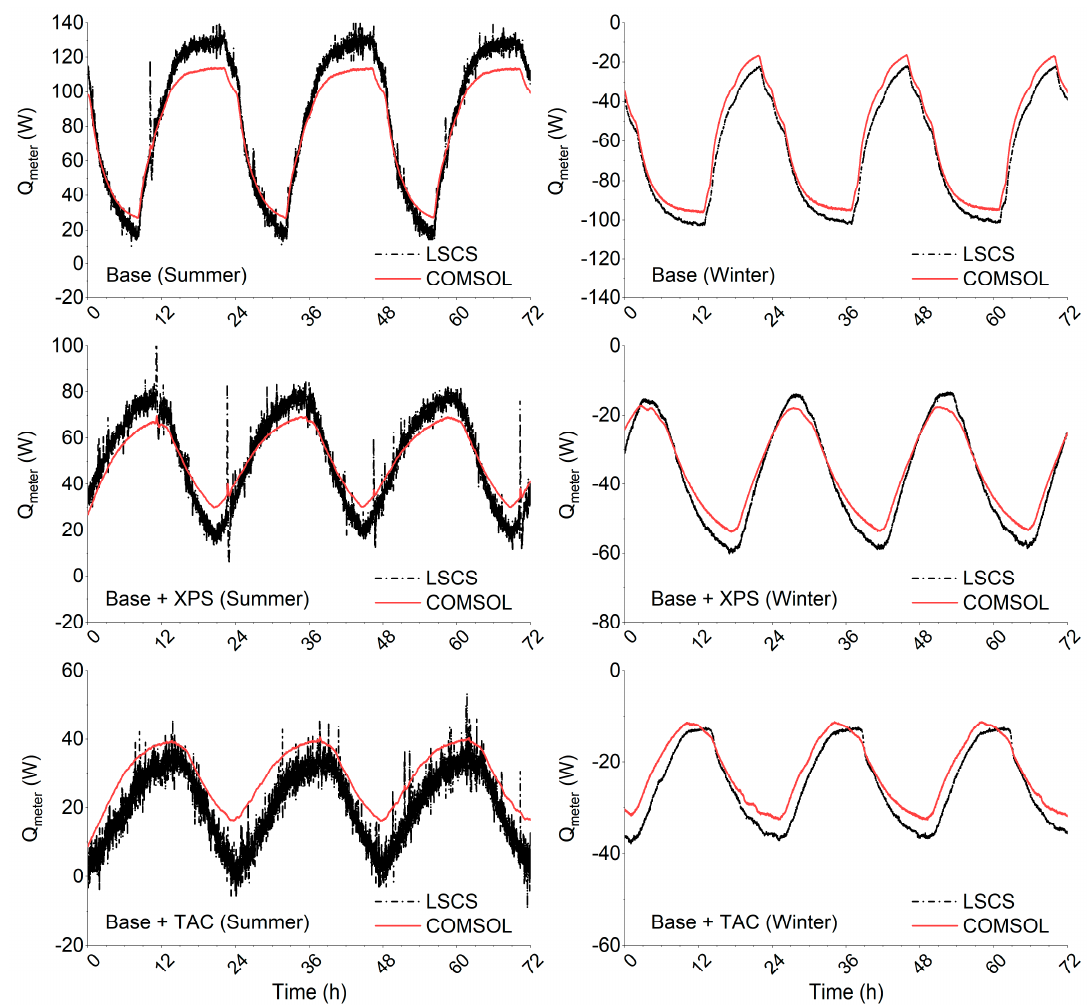
Figure 11. Comparison of measured and calculated heat gains to and heat losses from the meter chamber.